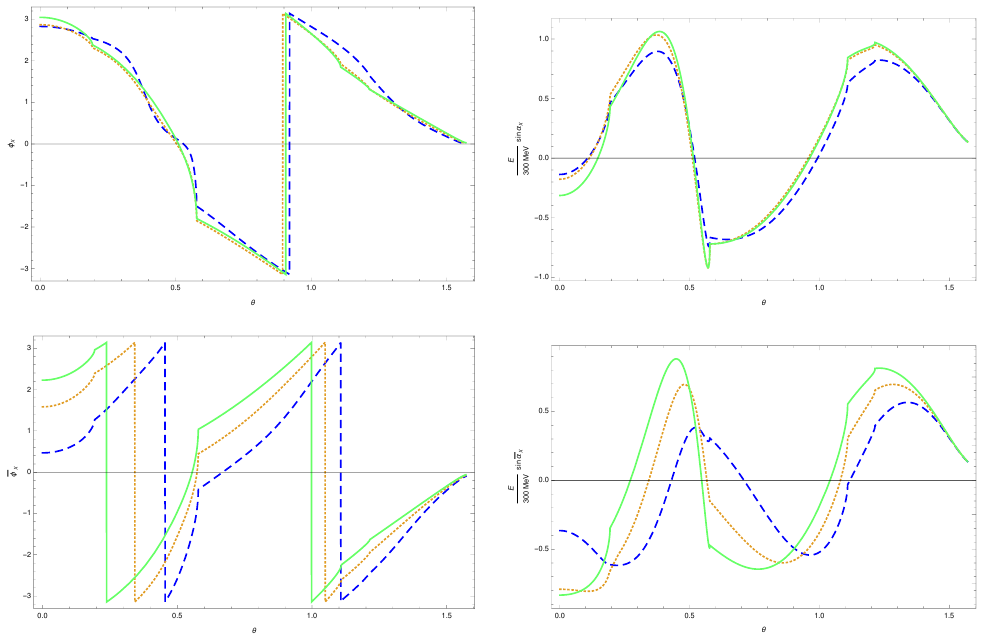
Figure 5 . Dependence of (cid:30) X ; (cid:22) (cid:30) X ; E sin (cid:11) X and E sin (cid:22) (cid:11) X obtained from numerical 300 MeV 300 MeV diagonalization on the azimuthal angle for the neutrino energies E = 300 ; 500 and 1000 MeV (blue dashed, orange dotted and green solid line, respectively). Normal mass ordering is